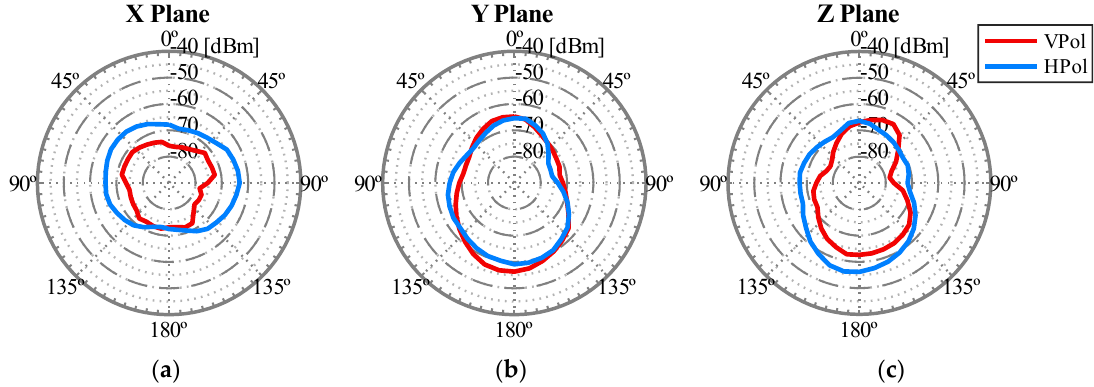
Figure 17. Radiation pattern of the WiTi on-board the UAV for the antennas configuration shown in Figure 13 in the U2G link working in 2.4 GHz: ( a ) X Plane, ( b ) Y Plane, and ( c ) Z Plane.